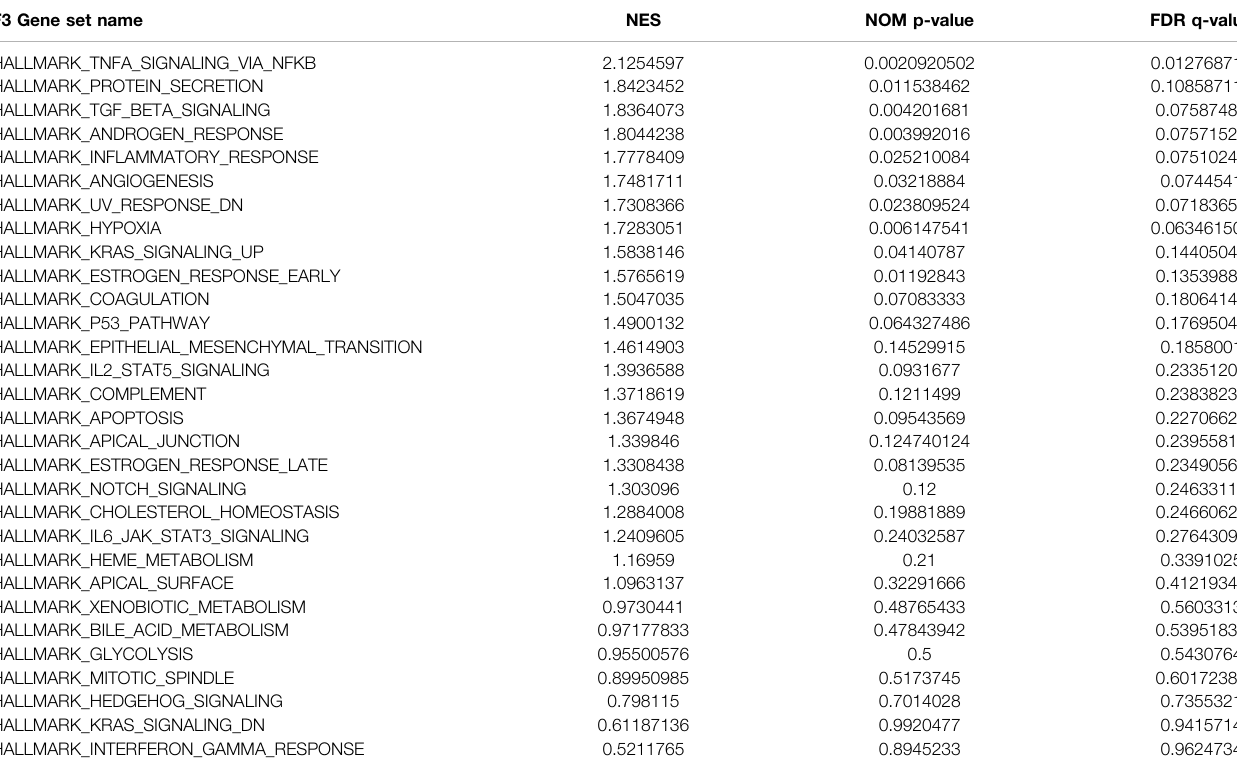
TABLE 2 | GSEA HALLMARK gene set data for